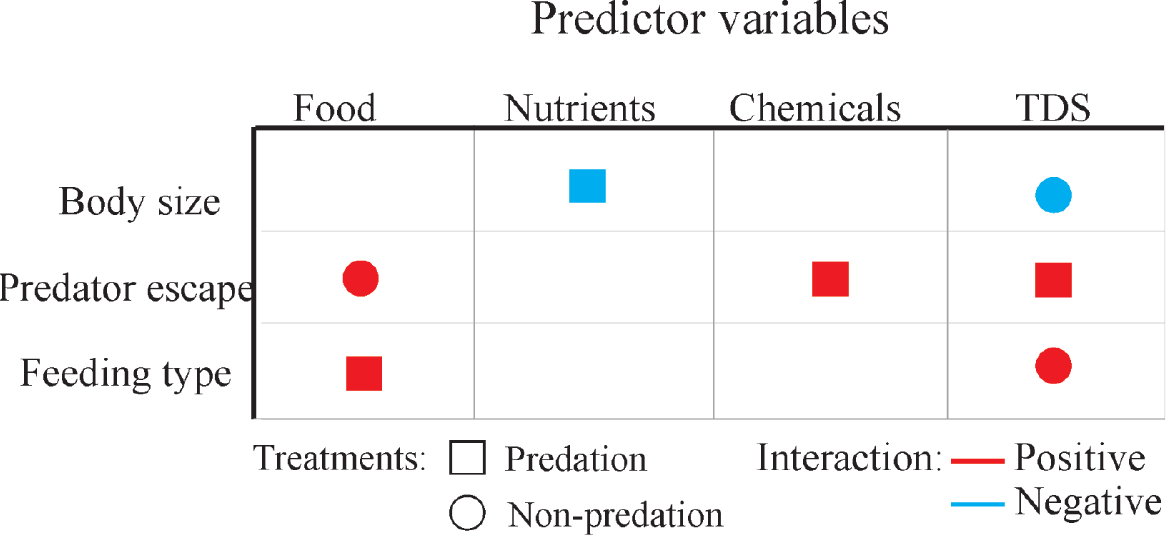
Figure 3. Graphic representation of significant correlations (p<0.05) of the Fourth-Corner analysis. The zooplankton functional traits are shown on the left side of the graph (rows) and the environmental variables (predictor variables) at the top of the graph (columns). Food represents the biomass of periphytic algae; nutrients are total nitrogen and total phosphorus; chemicals are pH and conductivity, and TDS is total dissolved